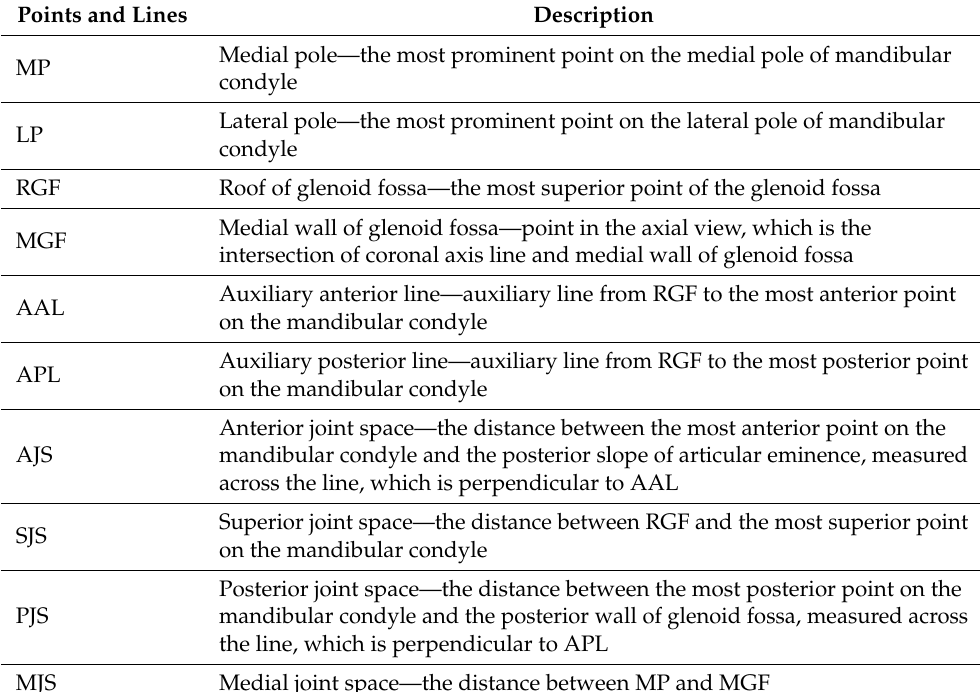
Table 2. List of points and lines used to analyze the position of mandibular condyle within the glenoid